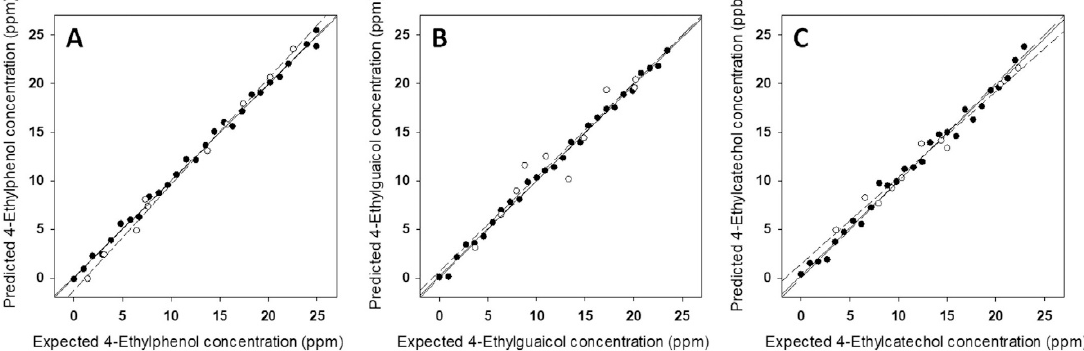
Figure 8. CV signals obtained for 25 ppm of 4-EP (black), 4-EG (red) and 4-EC (blue) in a wine matrix for ( A ) a bare epoxy-graphite electrode; and electrodes modified with ( B ) Cu nanoparticles; ( C ) WO 3 nanoparticles; ( D ) Bi 2 O 3 nanoparticles; ( E ) polypyrrole; and ( F ) Co(II) phthalocyanine. Reproduced from [85] with permission.